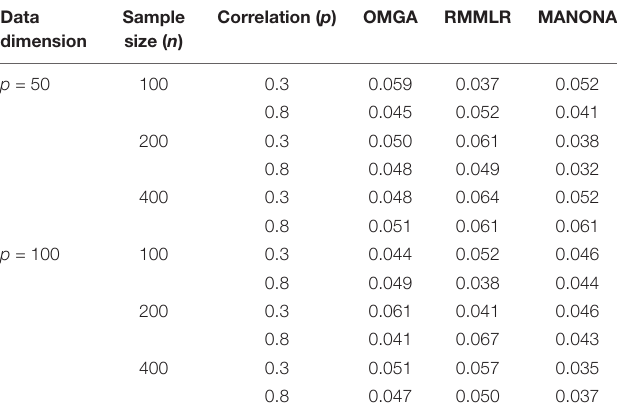
TABLE 1 | The type 1 error rate of different methods under different settings. Data